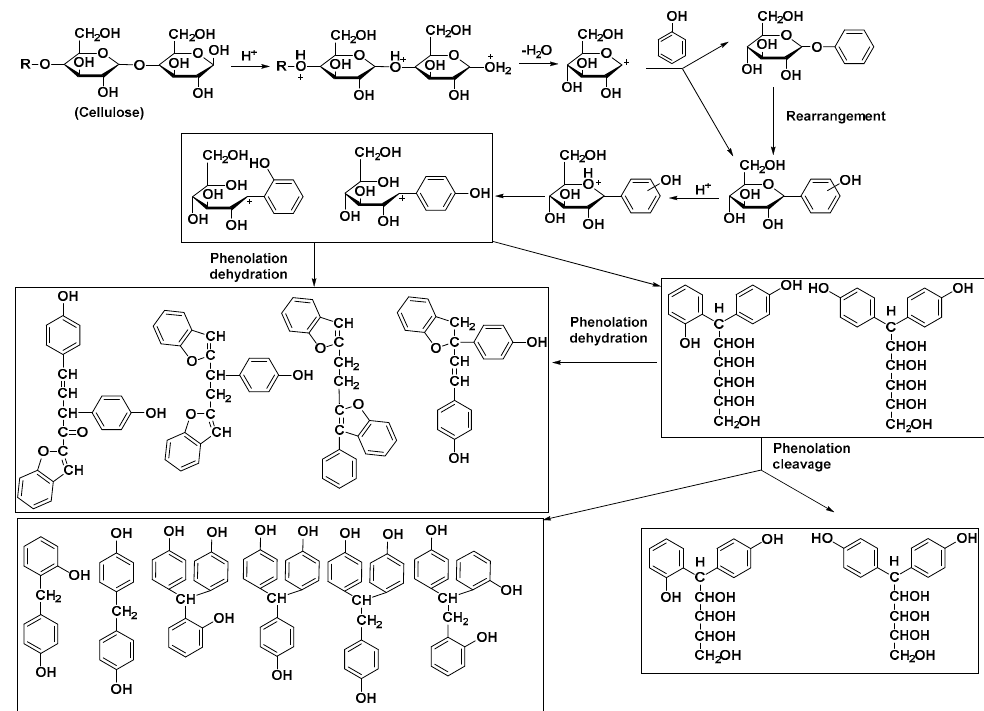
Figure 7. A proposed liquefaction pathway for cellulose in the presence of phenol under acid-catalyzed conditions (Adapted from [72]).